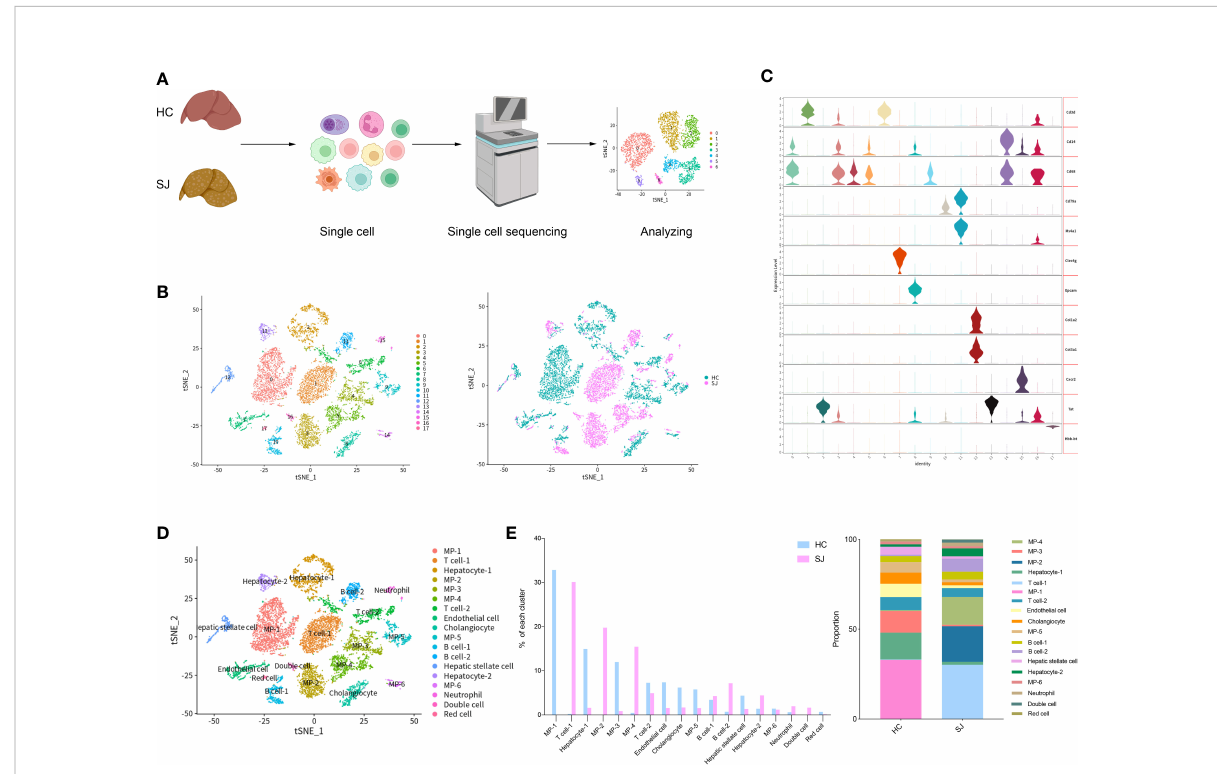
FIGURE 1 Overview of the 10,403 single cells isolated from liver of S. japonicum-induced mouse and normal mouse. (A) The fl owchart of our study including grouping, dissociating into single cell, sequencing and analyzing. (B) tSNE plot of different clusters and two groups [S. japonicum- induced mouse (SJ, n=1), health control mouse (HC, n=1)]. (C) Expression of marker genes in different clusters. (D) tSNE plot of annotation clusters. (E) The percentage change tendency of each cell cluster in two